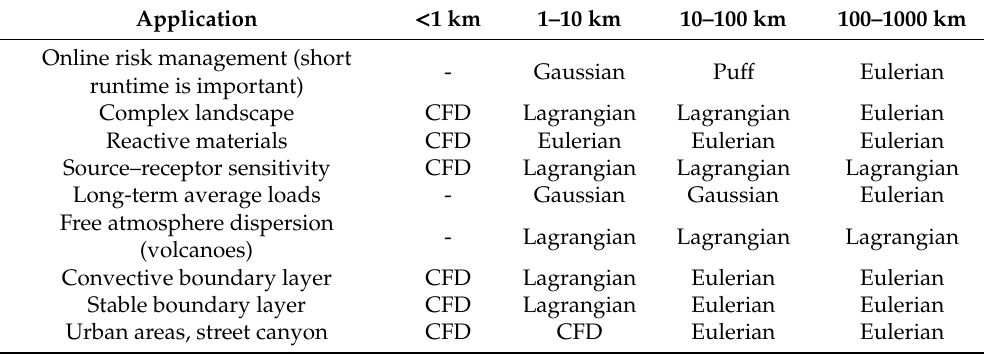
Table 1. Recommended approaches for di ff erent scales and applications of atmospheric dispersion modeling 1 .